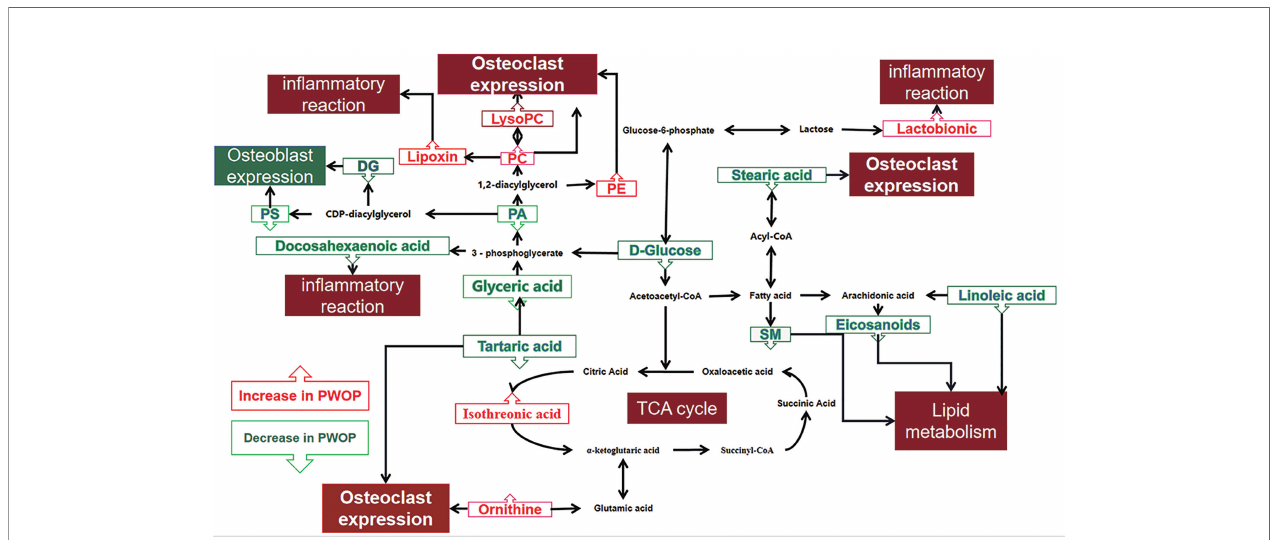
FIGURE 4 | Altered metabolic pathways for the most relevant distinguishing metabolites (potential biomarkers) between the case group and healthy control group. The metabolites with red border were upregulated in the case group, whereas those with green border indicate metabolites that were downregulated. PC, phosphatidylcholine; LysoPC, lysophosphatidylcholine; PE, phosphatidylethanolamine; DG, diacylglycerol; PS, phosphatidylserine; SM, sphingomyelin; PA, phosphatidic